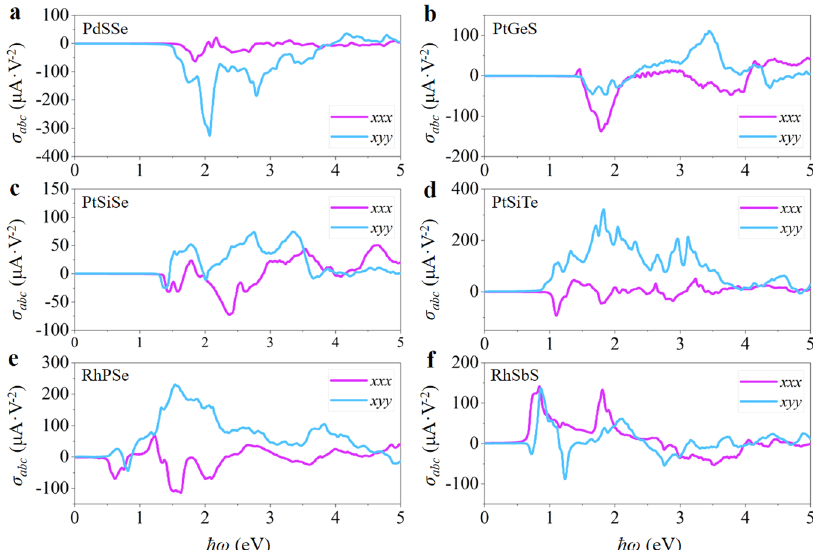
Fig. 5 BPVE response. Components of shift current tensor for pentagonal a PdSSe, b PtGeS, c PtSiSe, d PtSiSe, e RhPSe, and f